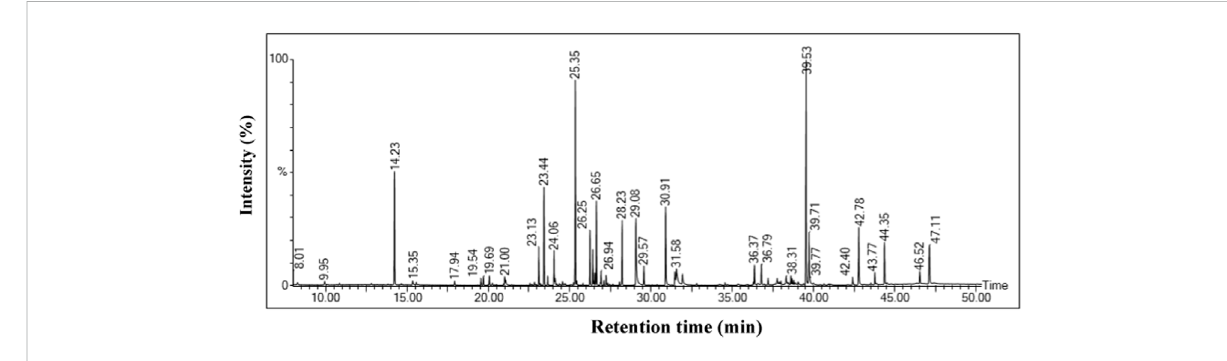
FIGURE 2 GC-MS chromatogram of Oroxylum indicum leaf extract.